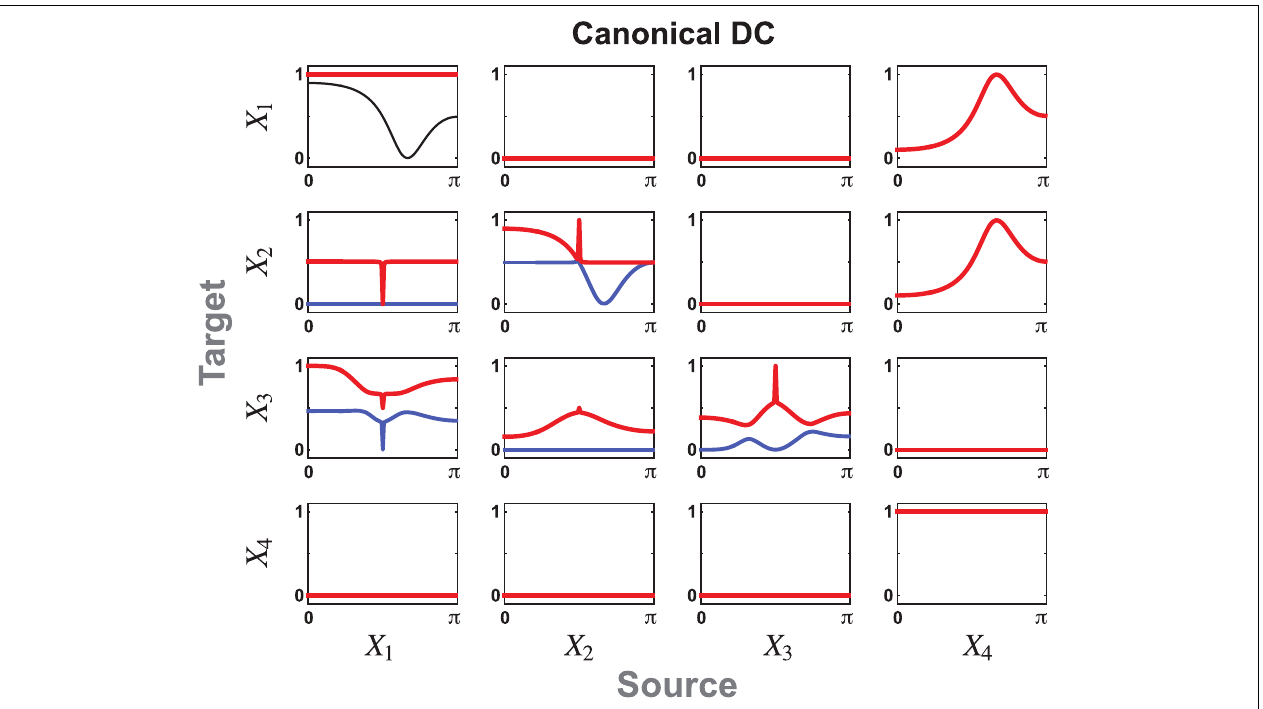
FIGURE 5 | cDC for Example 2 for a = − 1 leading to a cancelation of the effect of X 4 on X 3 as the signal travels indirectly through two exactly identical structures but with opposite phases before reaching X 3 . The notch filtering action is also apparent from the cDCs from X 1 to X 2 and X 3 .